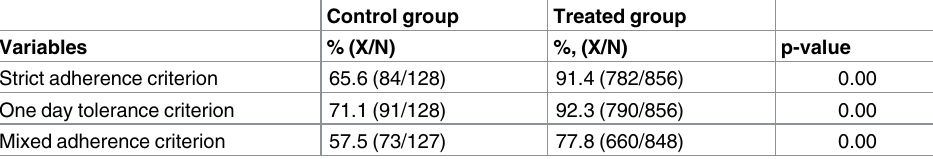
Table 2. Descriptive statistics of adherence to treatment.